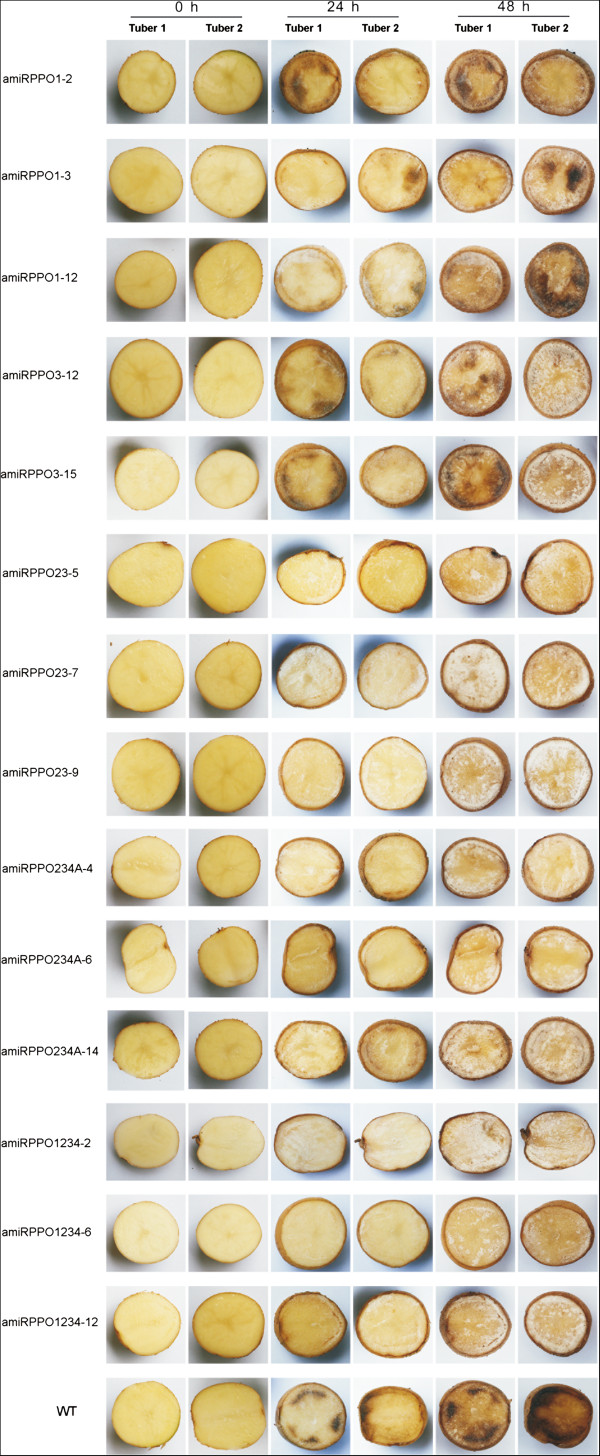
Browning phenotypes. Potato tubers from each transgenic line and wild type were randomly selected, cut into approximately two equal sections and exposed to air/oxygen at room temperature (~25°C). Images were taken at 0, 24 and 48 hour post air exposure. Browning or blackening typically started from vascular ring region and advanced to the medullary tissue with the air-exposure time.